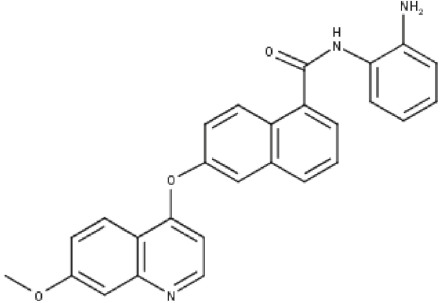
FIGURE 31 - Chemical structure of